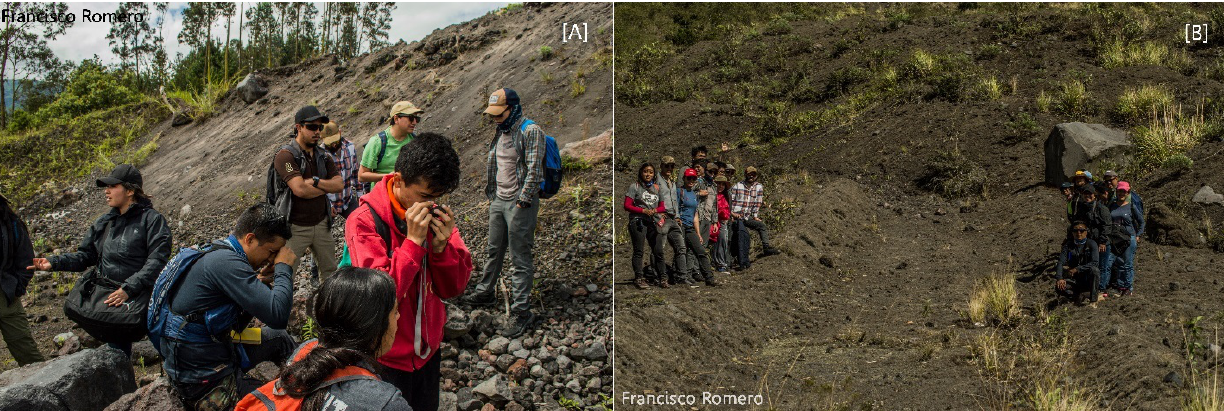
Figure 2: On the flanks of Tungurahua volcano, [A] students study deposits, and [B] pose near a levee from a pyroclastic density current deposit from the latest eruptive period.